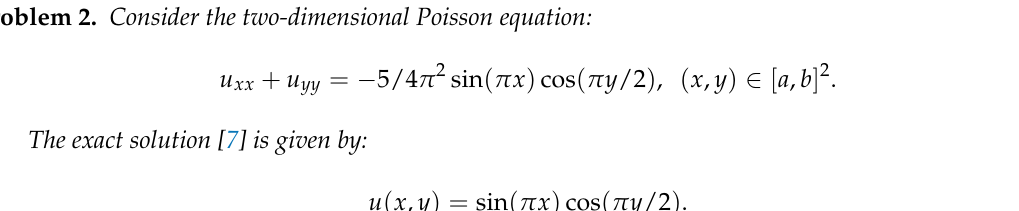
Figure 1. Numerical approximation ( left ) and L abs error norm ( right ) for Problem 1 for N =